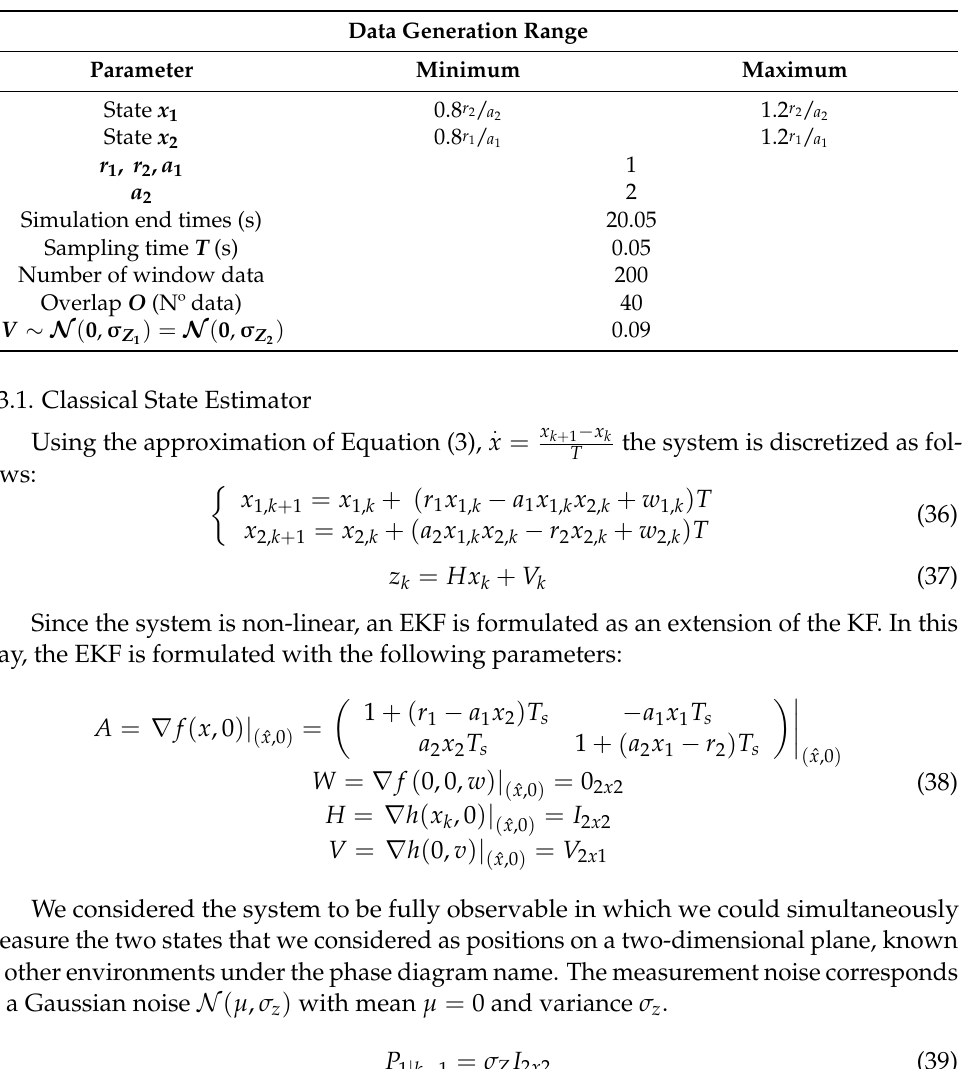
Table 3. Synthetic data generation parameters: Volterra–Lotka